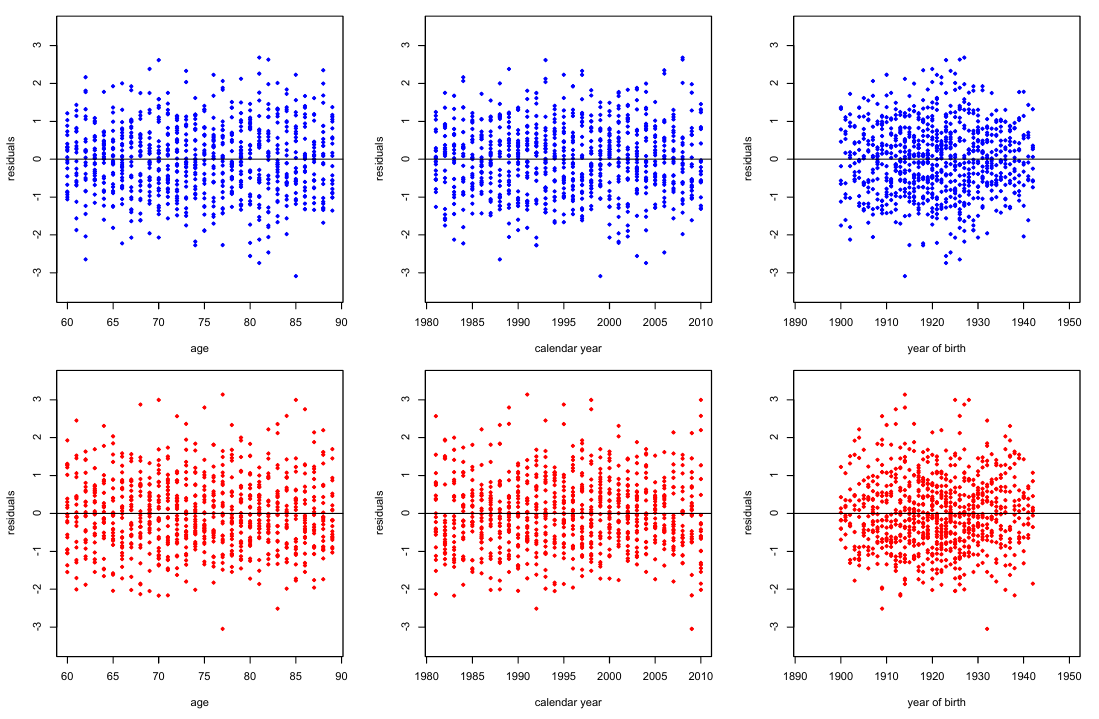
Figure 10. Residuals deviance of M 3 for males ( top panels) and females ( bottom panels) in Greece. Period 1981–2010, ages